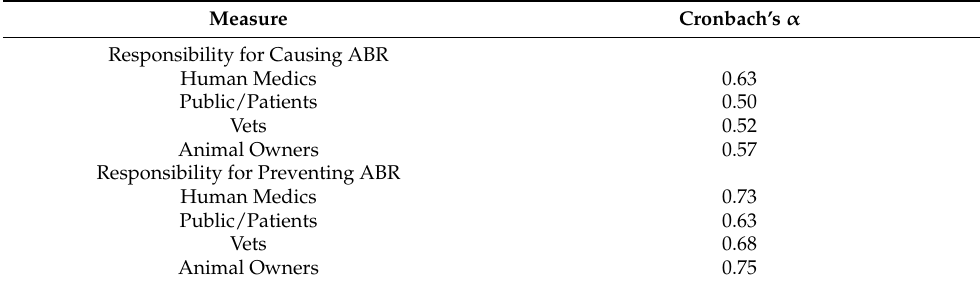
Table 8. Reliability statistics for beliefs